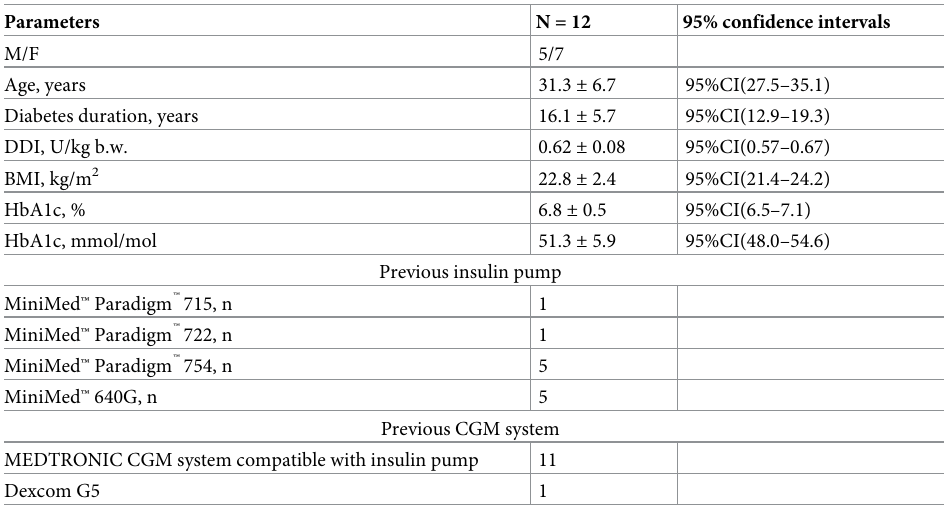
Table 1. Characteristics of the study